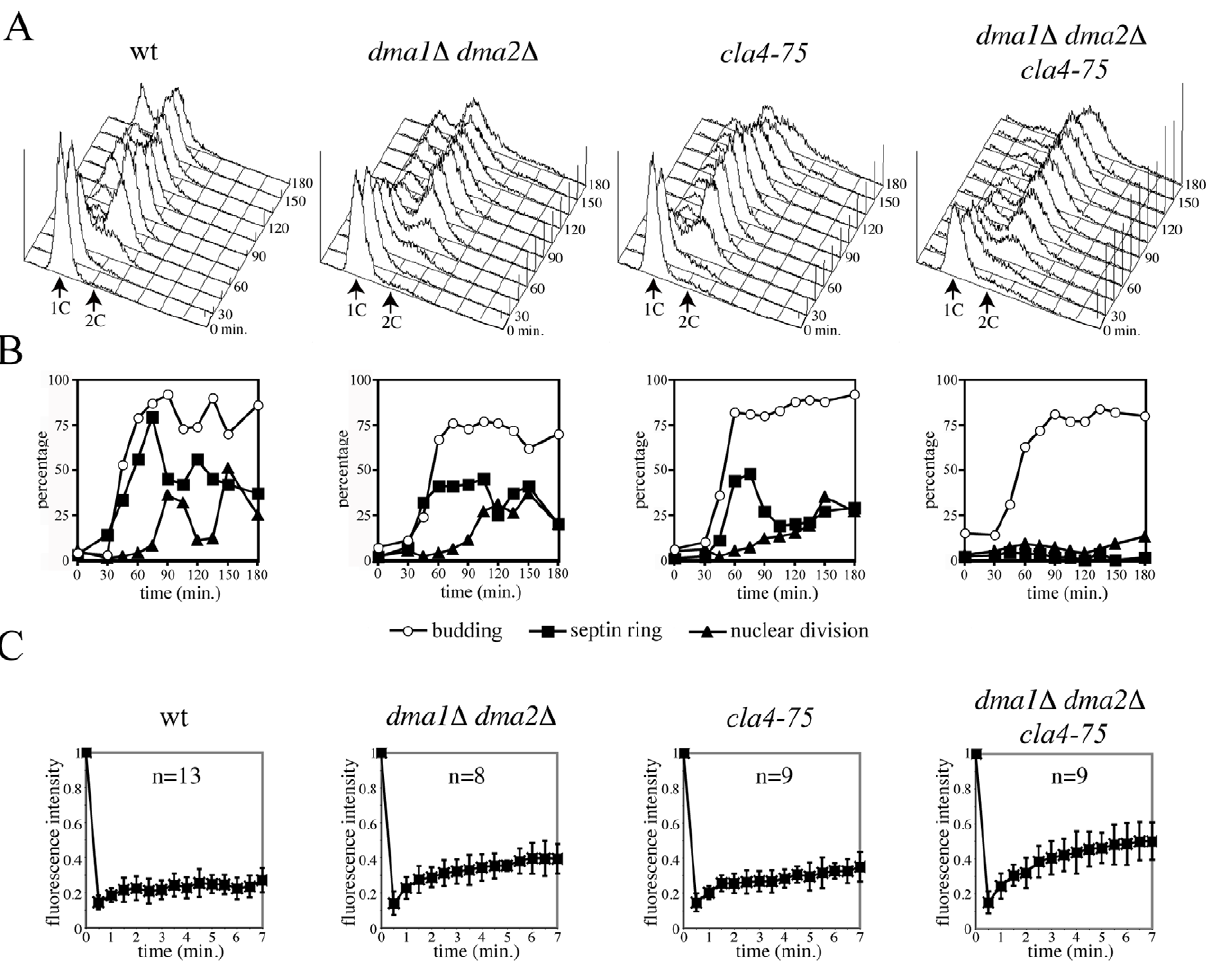
Figure 1. Dma proteins are required together with Cla4 for septin ring deposition. A–B: Logarithmically growing cultures of wild type (ySP3070), dma1 D dma2 D (ySP4319), cla4-75 (ySP4320) and dma1 D dma2 D cla4-75 (ySP4321) cells, all expressing a fusion of the Cdc3 septin with GFP, were arrested in G1 by alpha factor at 25 u C and released into the cell cycle at 37 u C. At the indicated times, cell samples were taken for FACS analysis of DNA contents (A) and for scoring budding, nuclear division and septin ring deposition (B). C: Septin rings labelled by GFP-Cdc12 were subjected to FRAP using the following strains: ySP8176 (wt), ySP8173 ( dma1 D dma2 D ), ySP8296 ( cla4-75 ) and ySP8193 ( dma1 D dma2 D cla4-75 ). Half of the ring was bleached at time 0. Recovery of fluorescence was measured over time upon shift to 37 u C and plotted as fraction of fluorescence intensity relative to time 0 (unbleached). Bars indicate standard errors.